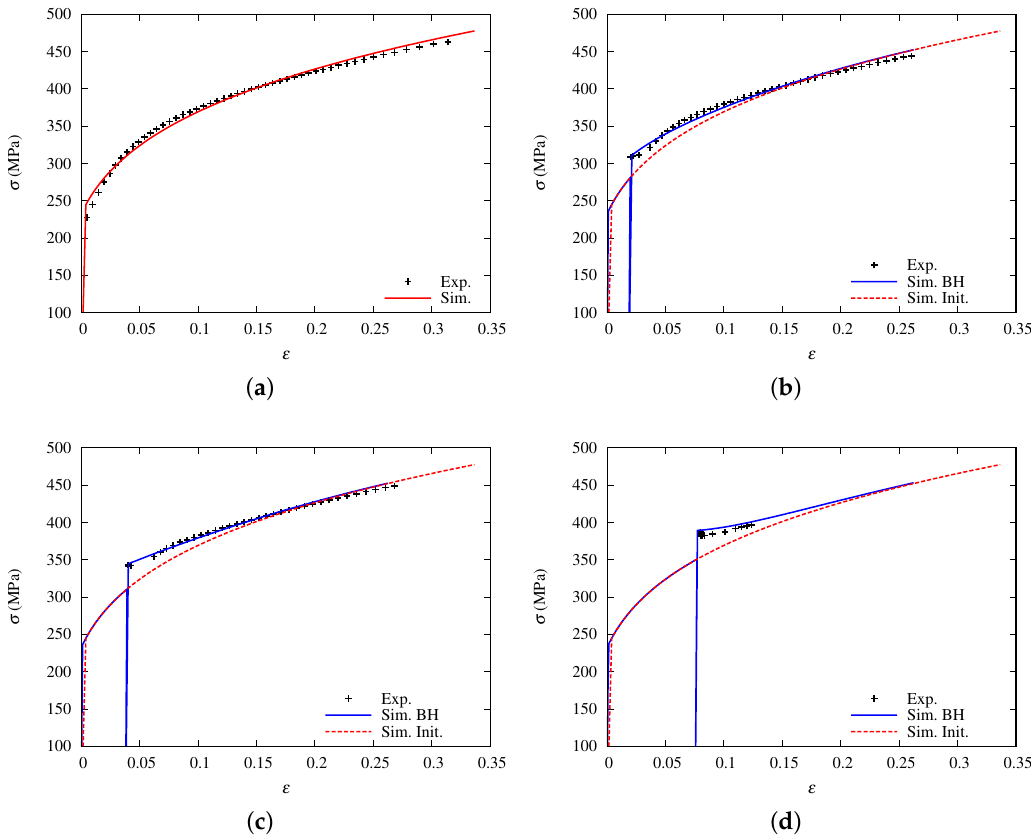
Figure 10. Modeling of the mechanical behavior. ( a ) Initial; ( b ) Pre-strain 0.02; ( c ) Pre-strain 0.04; ( d ) Pre-strain